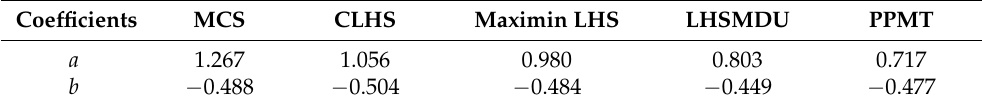
Table 2. The coefficients of the power law functions in the case where the OOIP variables are